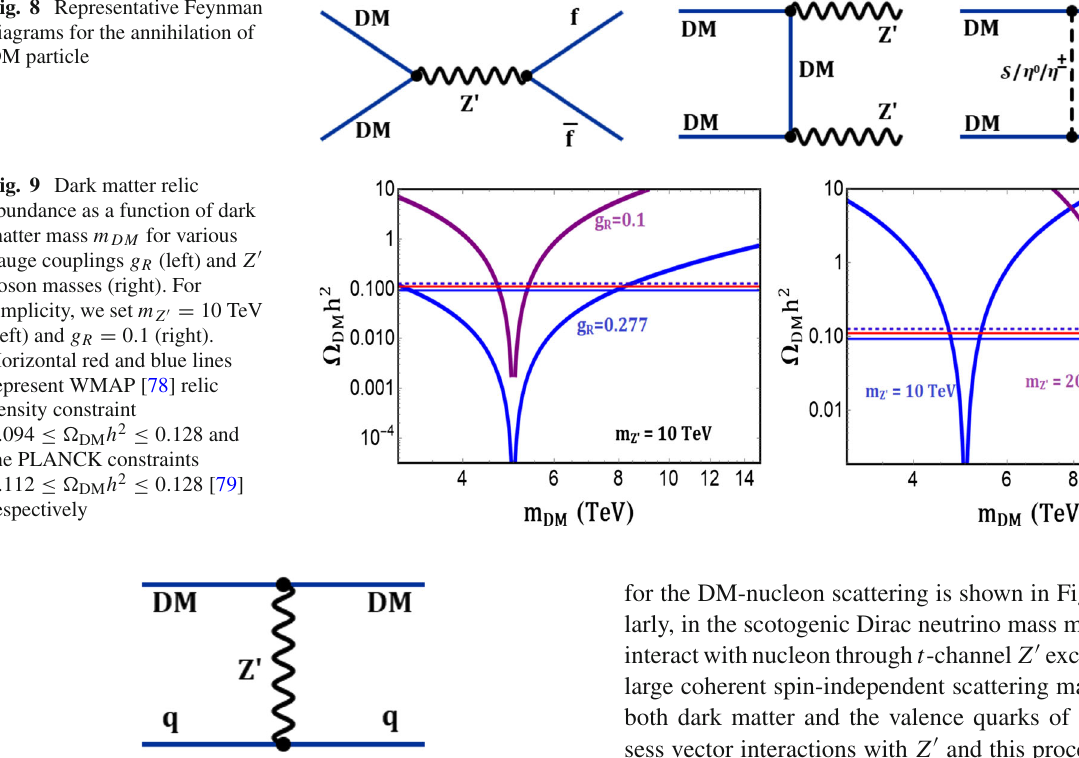
Fig. 8 Representative Feynman diagrams for the annihilation of DM particle